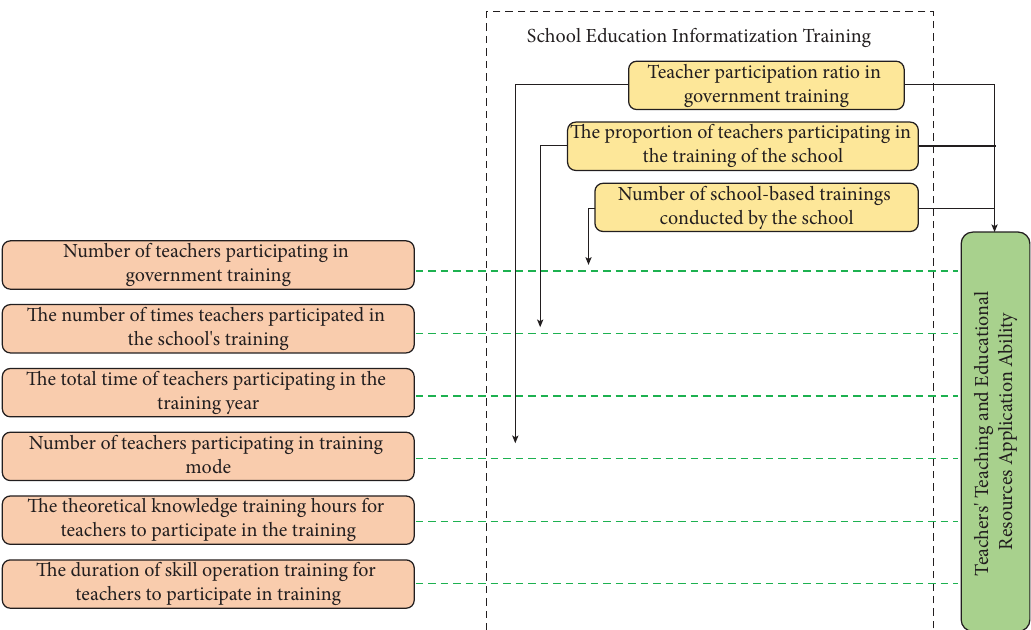
Figure 1: Hypothetical model of factors infuencing the application of digital educational resources for